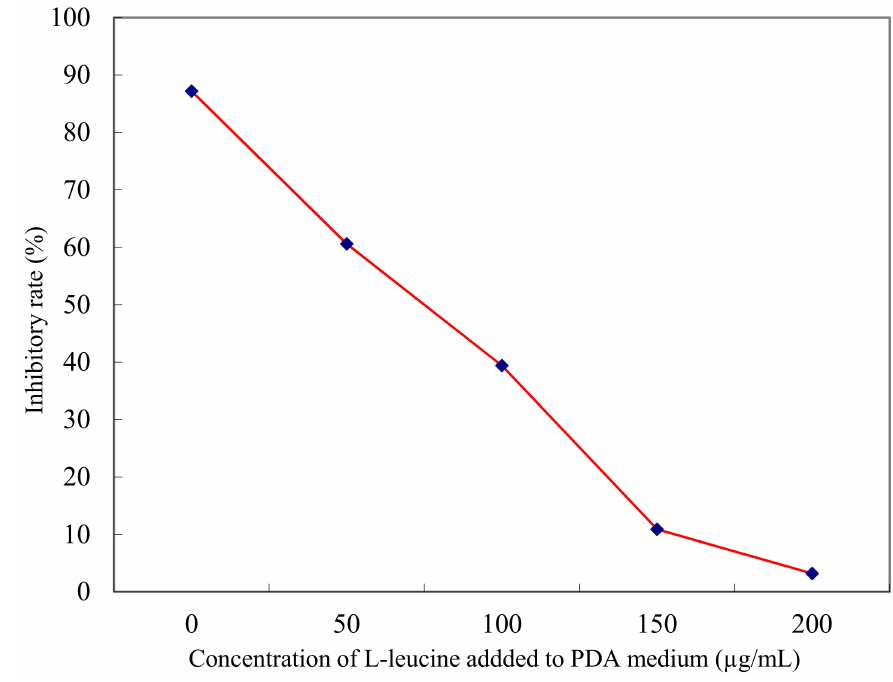
Figure 4. Anti-fungal effect of L -cyclopropylalanine reversed by L